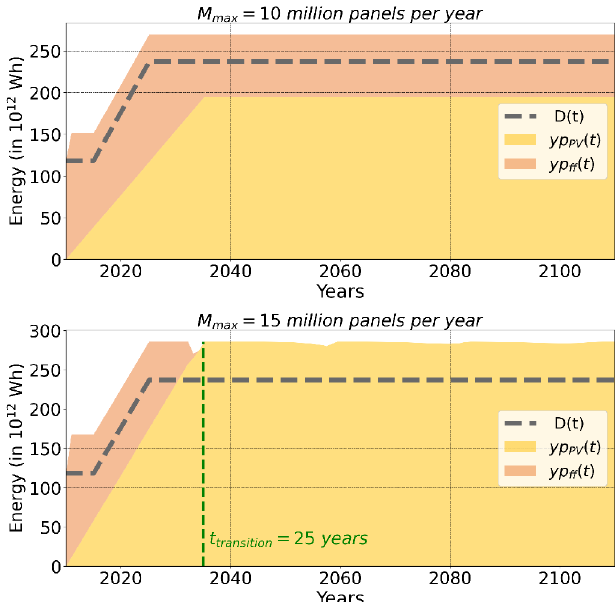
Fig. 3. Energy mix of France following the scenario A over 100 years, varying limitation of factory productivity M max , from 1 × 10 7 (upper) to 1 . 5 × 10 7 (lower) panels per year. Fossil fuel production (in orange), PV production (in yellow) and grid energy demand (dashed black line). Transition date t transition (in green) pinpoints when a 100% PV energy mix is reached.